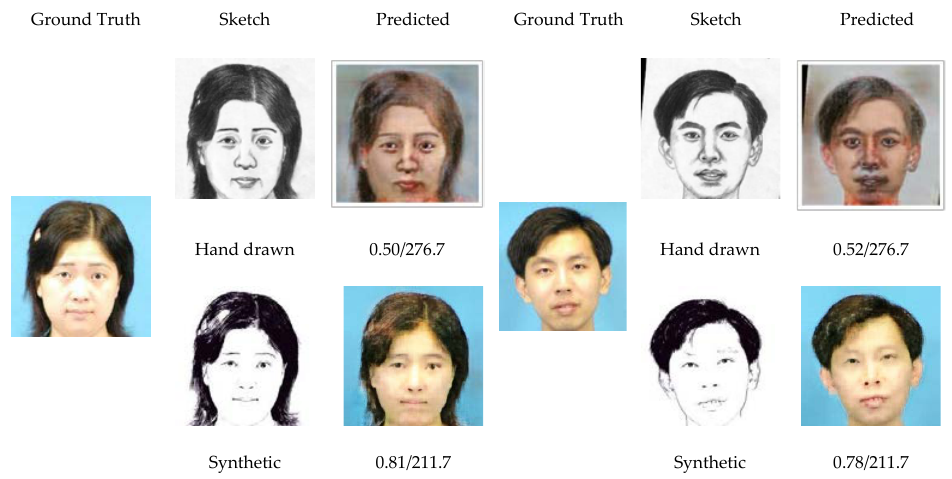
Figure 10. Results of our method using hand-drawn sketch input [20]. The values below the images represent SSIM/FID.